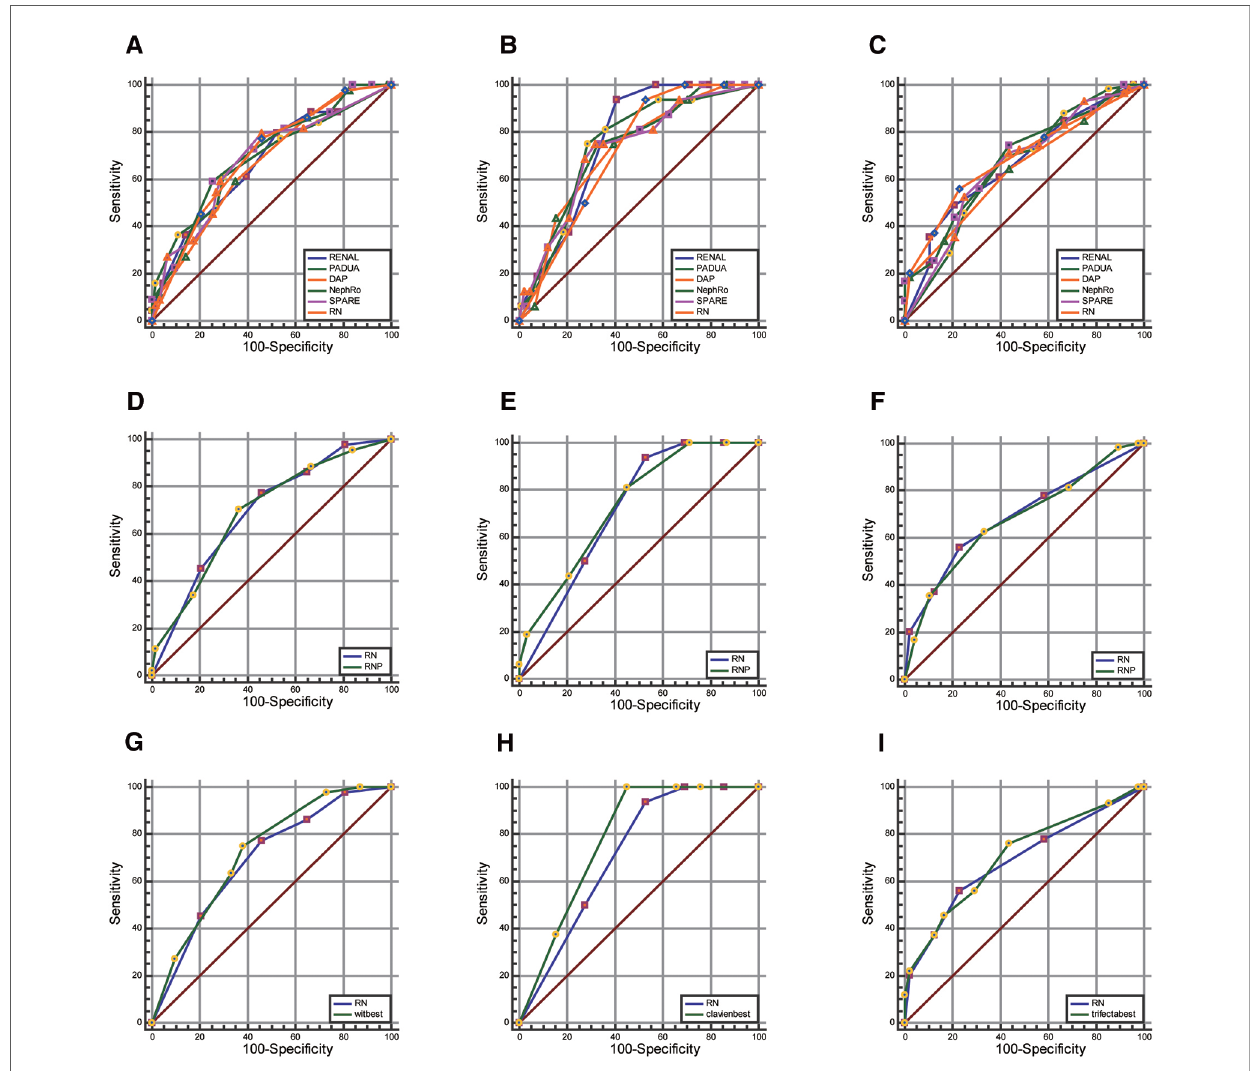
FIGURE 4 Comparison of AUC value between RN combination and traditional scores. ( A – C ), RNP score ( D – F ) and strongest element combination ( G – I ) in predicting warm ischemia time (wit >20 min, fi rst column), postoperative complications (CD grade ≥ II, the second column), and whether to achieve trifecta (Third